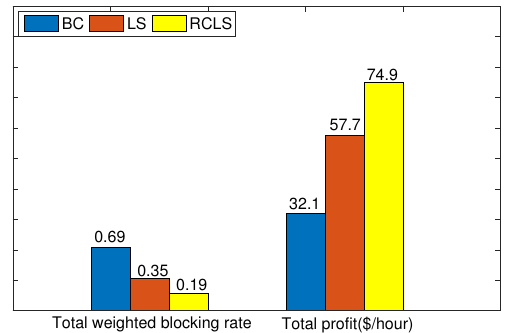
Figure 6. Summary of performance comparison.